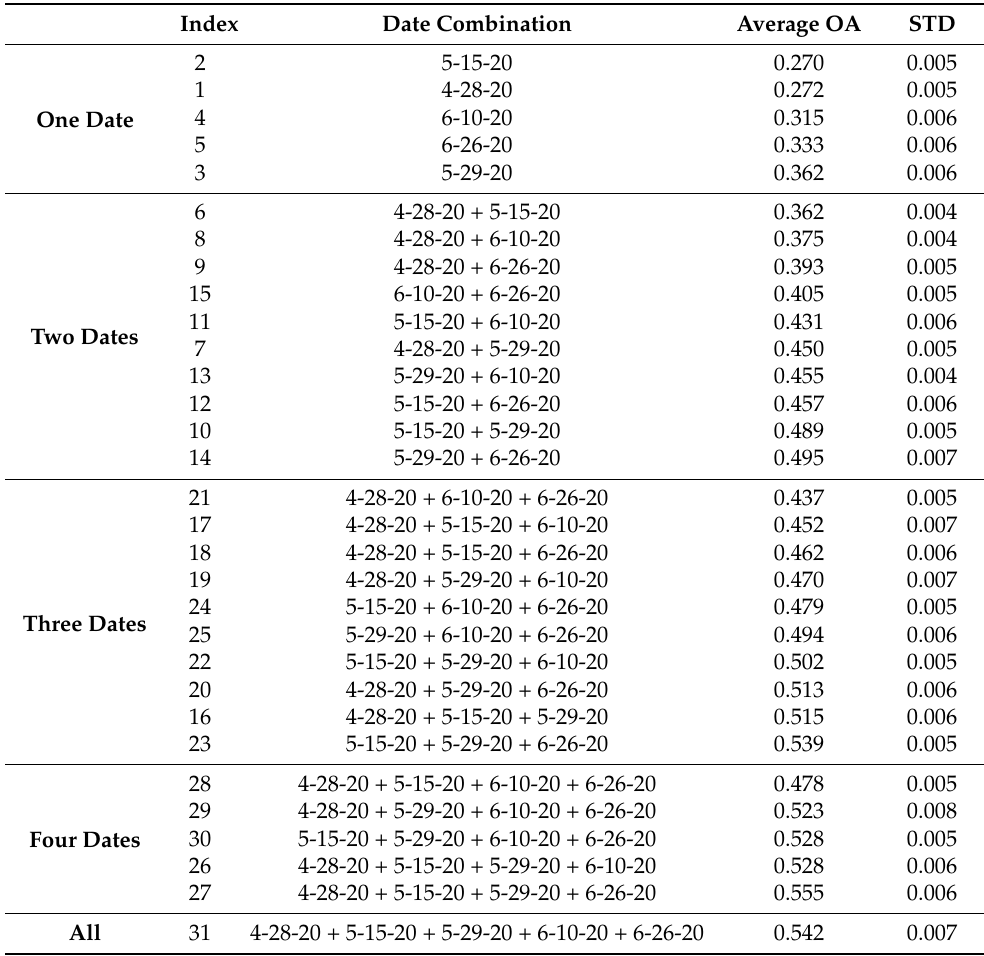
Table A2. Accuracy for all Sequoia classifications. Overall accuracy (OA) is reported here as the average OA of the 30 classification iterations performed for each combination. The standard deviations (STDs) are given. The results are sorted by the number of dates included in the combination and the average